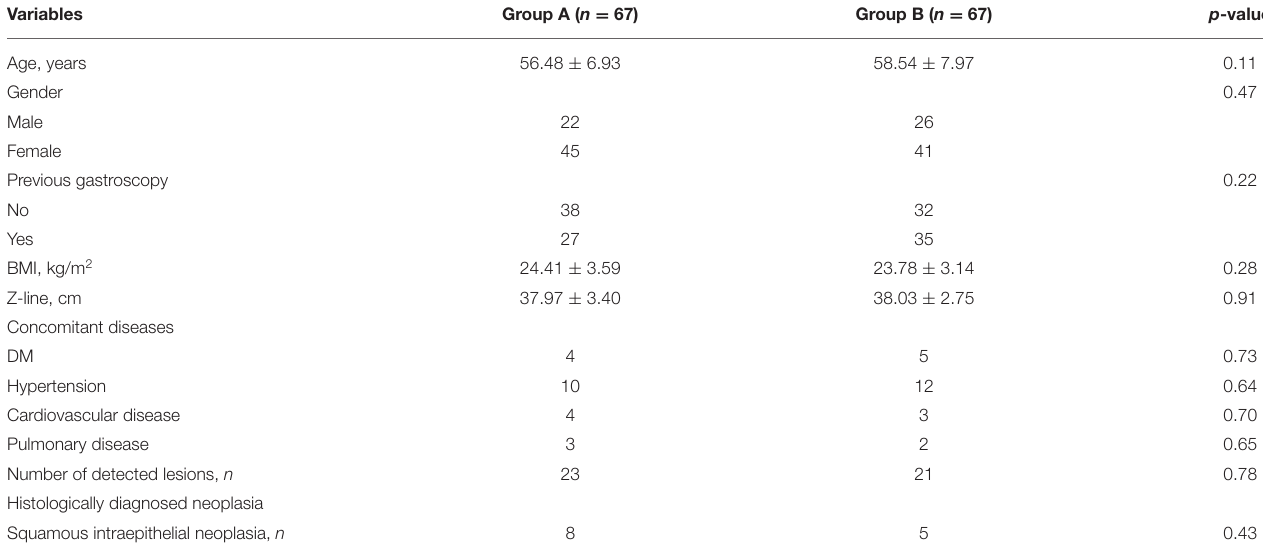
TABLE 1 | Characteristics of patients and procedure